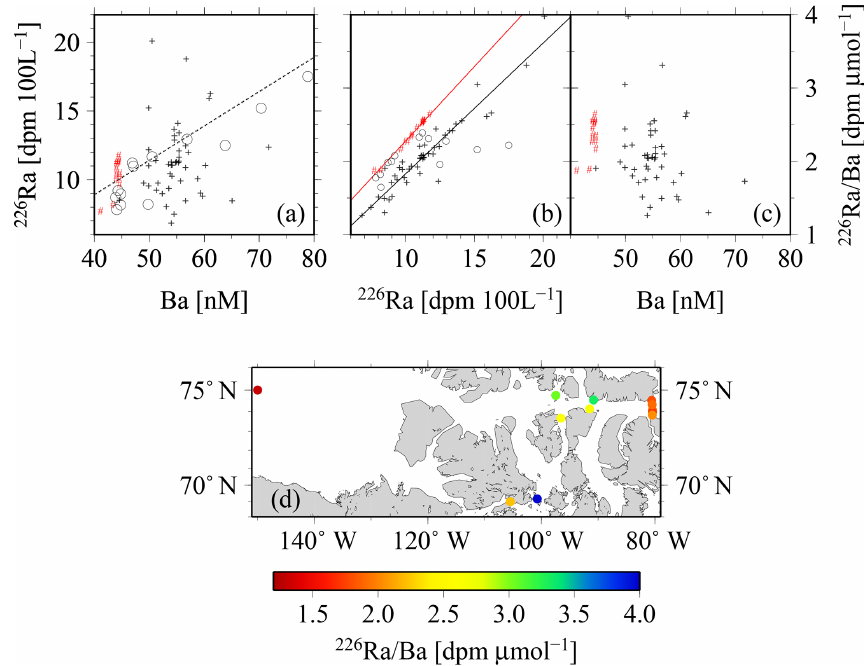
Figure 13. The relationships between (a) 226 Ra and Ba, and the relationships between 226 Ra / Ba and the (b) 226 Ra and (c) Ba concentrations. The red symbols indicate samples with S P > 34 (Atlantic origin). In panel (b) , the linear regressions yield f (x) = 0 . 20 x + 0 . 25, R 2 = 0 . 99, for samples with S P > 34, and they yield f (x) = 0 . 18 x + 0 . 05, R 2 = 0 . 90, for samples with S P < 34. Within panels (a) and (b) , open circles are drawn from van Beek et al. (2007), whereas the dashed line in panel (a) is redrawn from Le Roy et al. (2018). Panel (d) depicts the spatial distribution of the 226 Ra / Ba in surface waters across the CAA. Table 2. Apparent dissolved inorganic carbon (DIC, µmolkg − 1 ), total alkalinity (AT, µmolkg − 1 ), δ 18 O, barium (Ba, nM), 226 Ra ter (SIM and MW), the upper halocline layer (UHL), and the Atlantic layer (ATL) from PC1 of the original eight-variable PCA (Fig. 7) with the exception of 226 Ra, which does not significantly coincide with